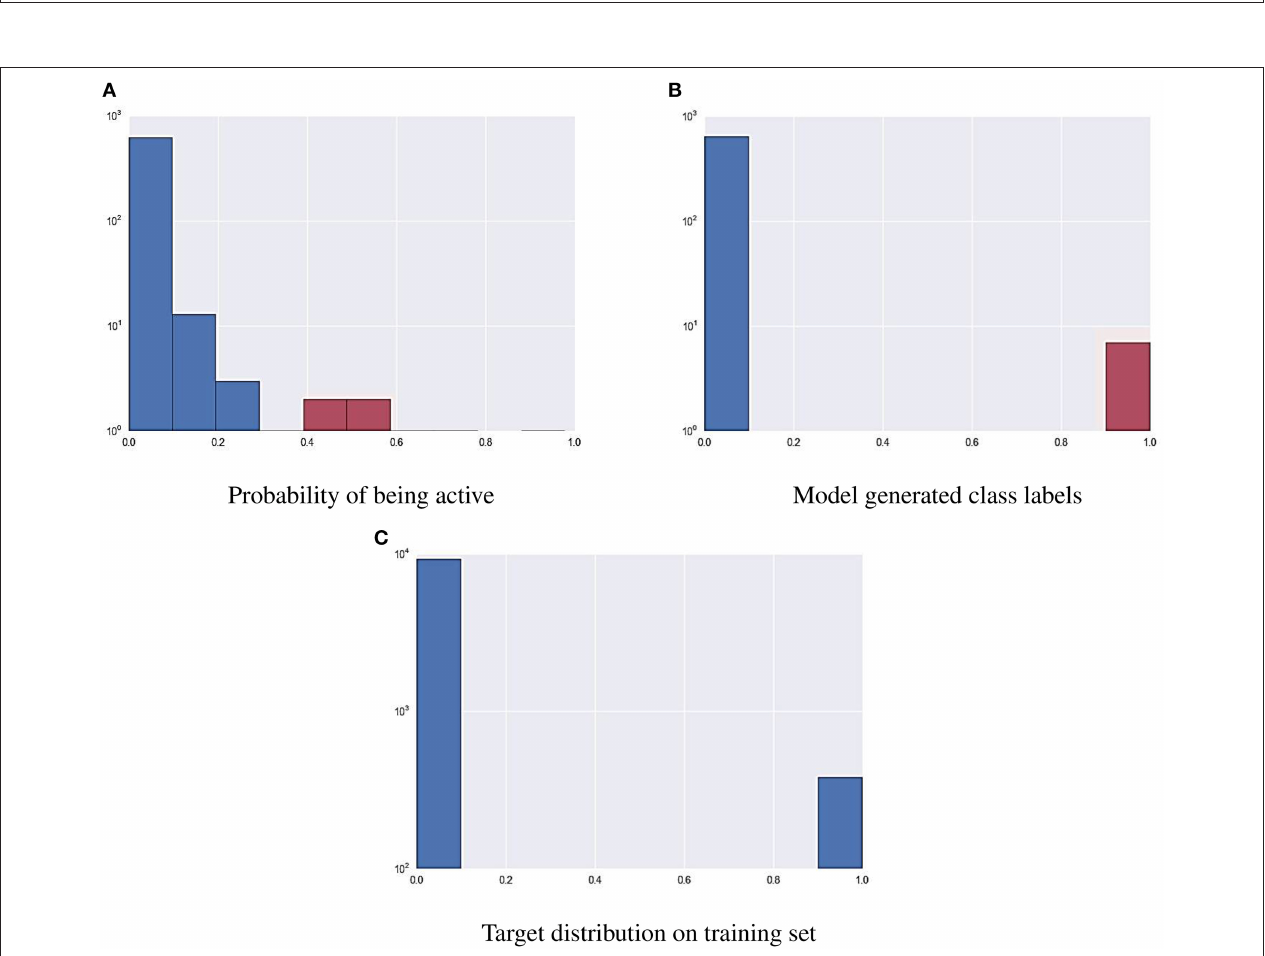
FIGURE 7 | Using a cutoff threshold on assay NR-AR to transform probabilistic predictions (A) to actual activity (B) that resembles training distribution (C).